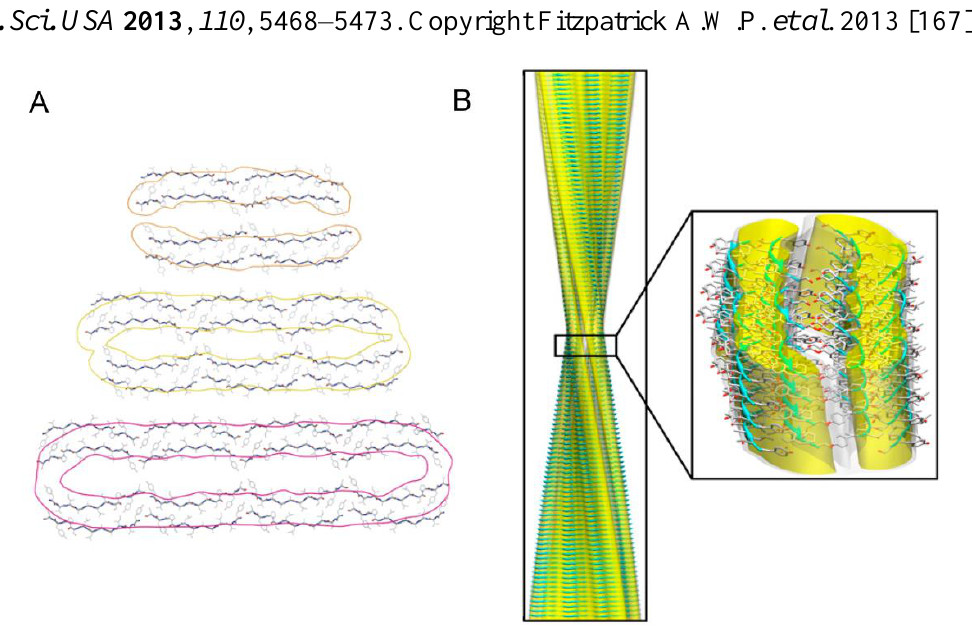
Figure 4. Polymorphism of TTR(105–115) amyloid fibrils. ( A ) All-atom representation of the doublet (top), triplet (middle), and quadruplet (bottom) fibril cross-sections with cryo-EM envelopes superimposed. ( B ) Atomic-resolution structure of the triplet fibril fitted into the cryo-EM reconstruction. Modified from Fitzpatrick A.W.P. et al ., Proc.